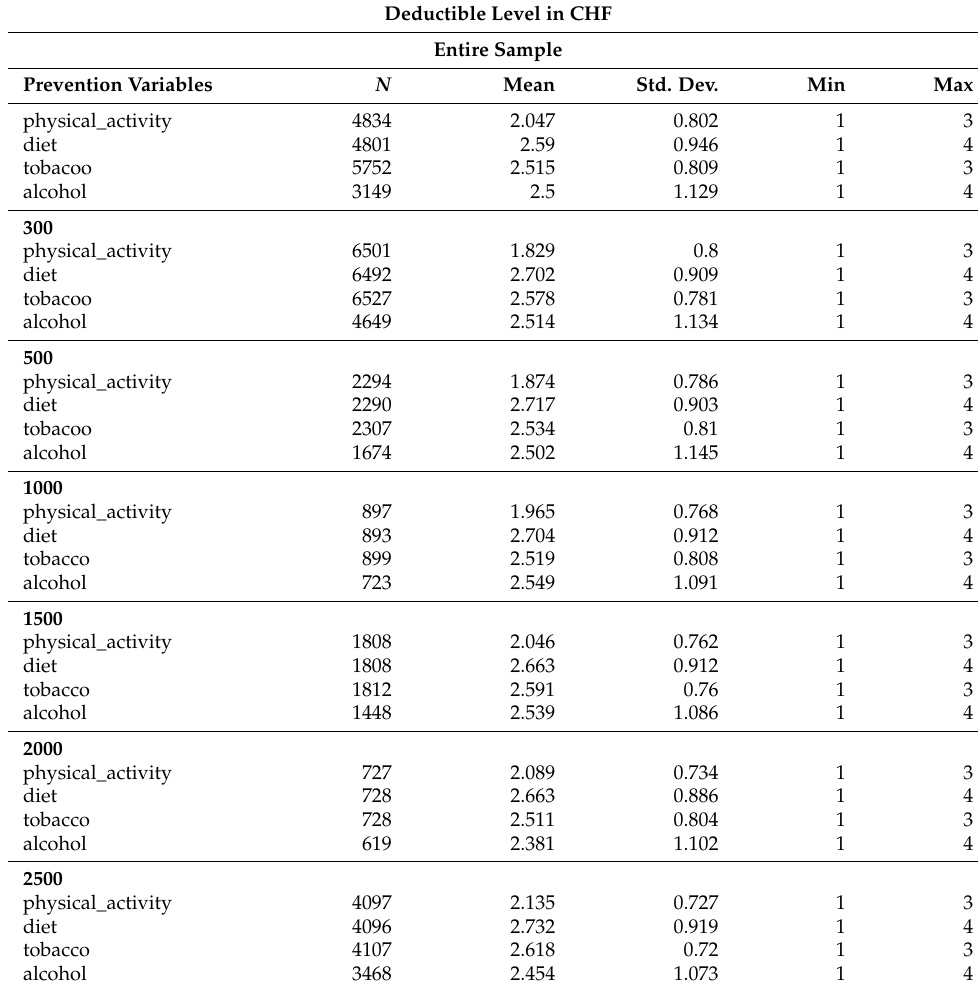
Table 2. Descriptive statistics of the prevention variables by deductible